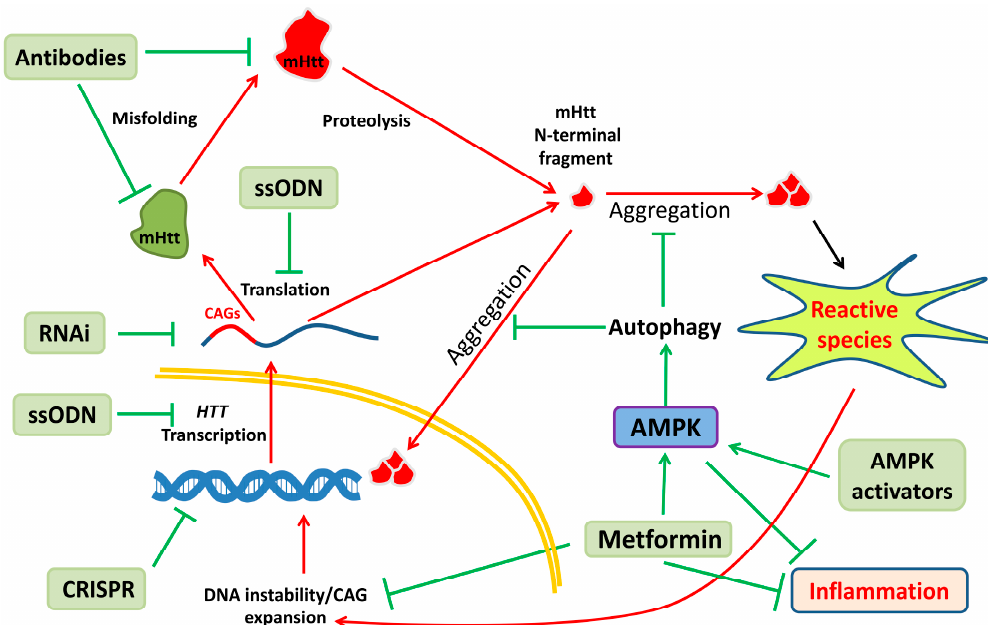
Figure 2. Strategies to reduce the expression of mutant huntingtin. The expression of mHtt causes a range of catastrophic events that disrupt neuronal functions, which can lead to cell death: gene expression disruption, abnormal expansions of CAG tandems, autophagy disruption, oxidative stress, etc. Many strategies to stop the progression of these events have been assayed, such as targeting oxidative stress by scavenging free radicals. However, the sources of reactive species remain, and further free radicals may be produced. We suggest that removing the cause of the production of these reactive species may be a more e ffi cient way to treat HD. For example, ablation of the mutant allele of HTT by means of CRISPR will stop the production of mHtt, constituting a permanent cure for HD. This strategy lacks maturity; knocking down the gene using ssODN or RNAi may be a more practical approach. Antibodies against mHtt can be designed with ubiquitine ligase domains, and once introduced into cells, can target the toxic mHtt to degradation. Finally, mHtt can be degraded, taking advantage of the natural pathway of damaged protein clearance of the cell, autophagy. Activators of AMPK, a well-known autophagy inducer, may be considered as potential HD treatments, because they can reactivate autophagy in cells stressed by mHtt, which is ussually blocked in mouse models and patients with HD. The activation of AMPK results in reduced inflammation. Metformin has been shown to be a good candidate to reduce toxicity induced by mHtt. This drug is a regular treatment for type 2 diabetics, so its use has been widely investigated, and it has been shown to have few side e ff ects. Metformin shows strong anti-inflammatory and antioxidant properties, AMPK-dependent and independent, and induces DNA stability, which may be useful to stop expansions of CAG tandems.